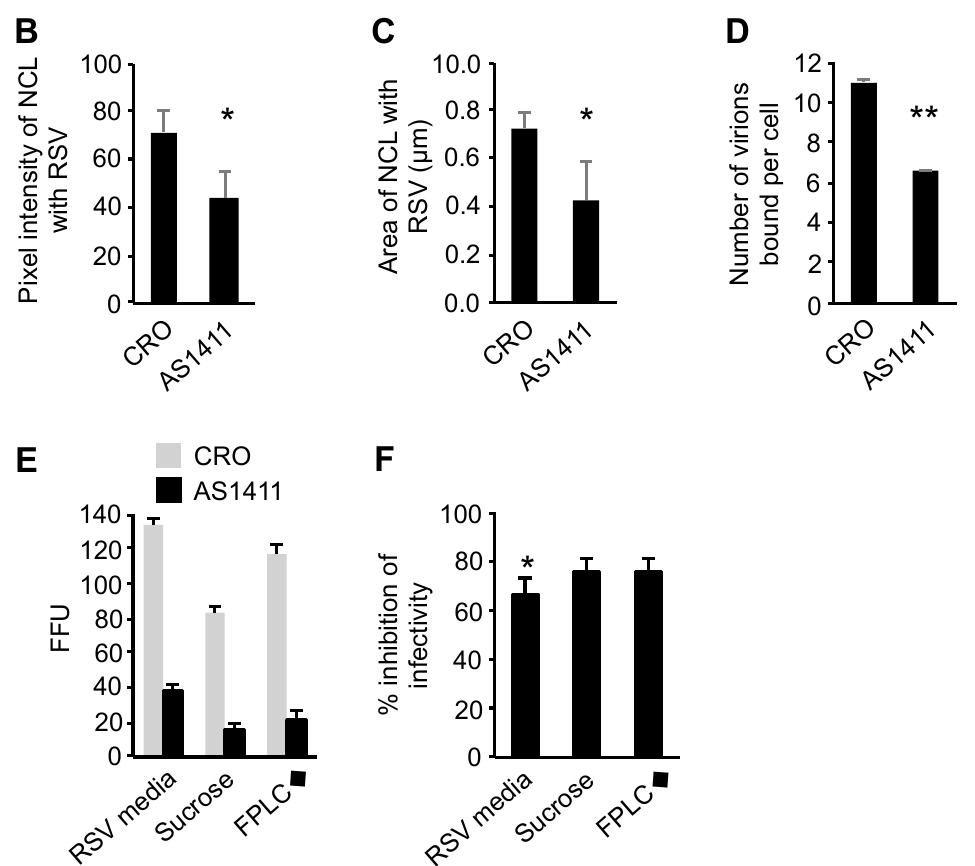
Figure 3. The susceptibility of RSV stocks to nucleolin (NCL) receptor blocking by the DNA aptamer, AS1411. ( A – F ) 1HAEo- bronchial epithelial cells were treated with 5 μ M CRO control aptamer or AS1411 aptamer for 1 h and then inoculated with equivalent infectious units of RSV. ( A ) The interaction of RSV with NCL was observed and quantified by imaging flow cytometry 60 min after infection. A representative ImageStream array is shown that demonstrates the typical patching of NCL that was associated with RSV binding to the cell surface. The differential interference contrast (DIC) and the fluorescent images are provided and the scale bar represents 10 μ m. When images were gated on RSV particles bound to the surfaces of cells, there was a significant decrease in the ( B ) mean NCL pixel intensity, the ( C ) mean area of the NCL patch; and the ( D ) mean number of RSV particles bound per cell. * p < 0.05, ** p < 0.01 by Student’s t test. Experiments are representative of two independent experiments that used a prototypic RSV-A2 and a clinical isolate of RSV type-A; ( E ) Aptamer pre-treatment and equalized RSV infection was allowed to proceed for 20 hours before the monolayers were stained and enumerated; ( F ) Percent inhibition of RSV infection was determined by dividing the AS1411 infectivity by the CRO infectivity in panel ( E ) then multiplying by 100. * p < 0.05 by Student’s t test.